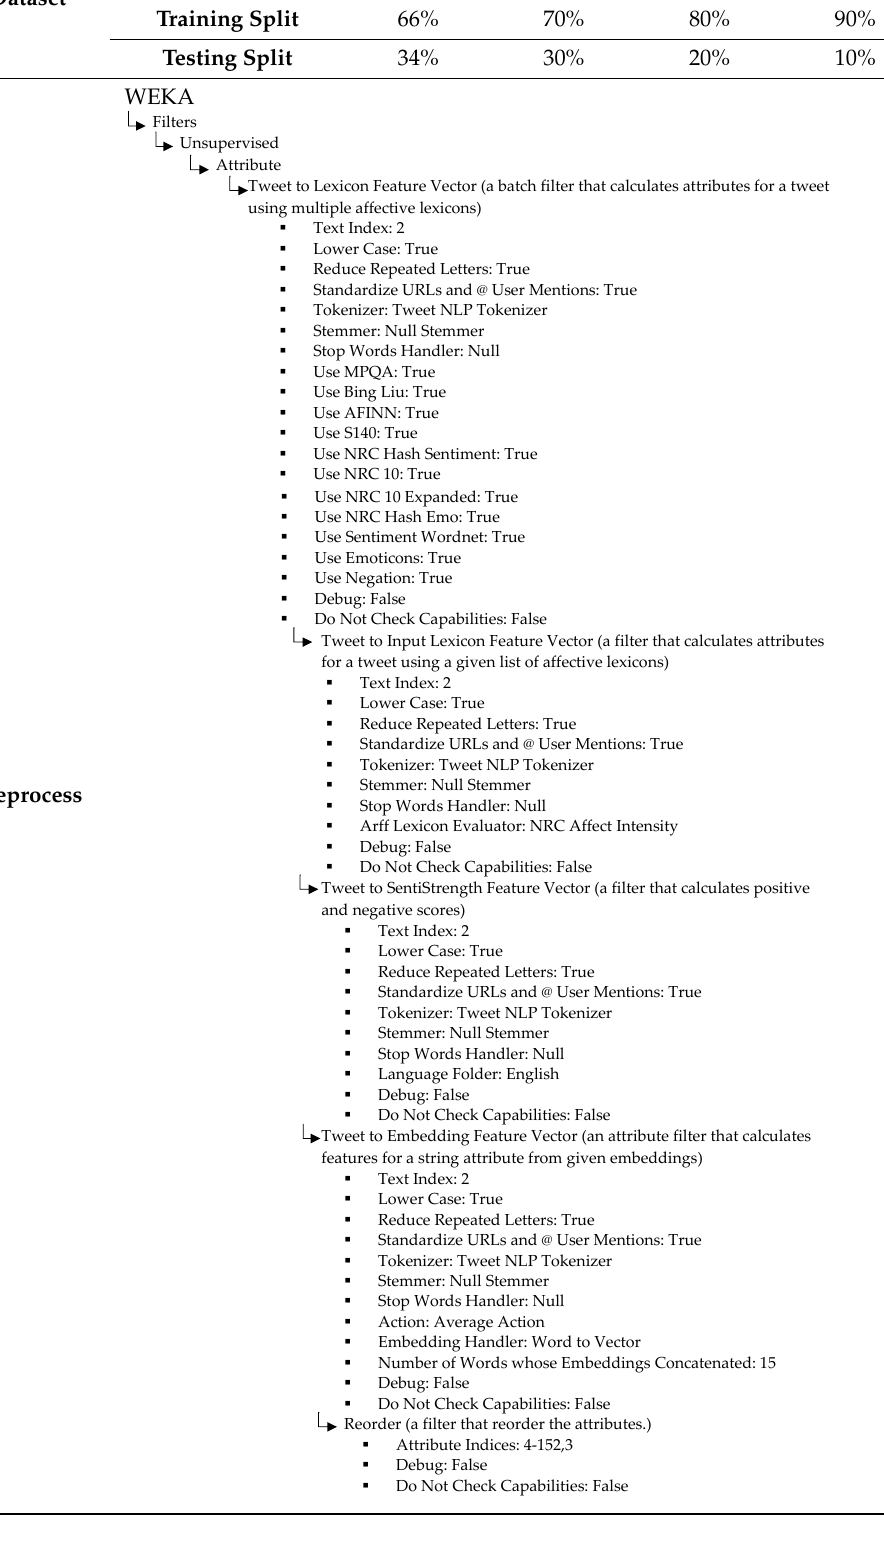
Figure 7. Graphical representation of confusion matrix (single feature selection technique). Table 6. Run information (tetrad feature selection techniques). Table 6 and the findings of the model used in all the tests. Table 6. Run information (tetrad feature selection